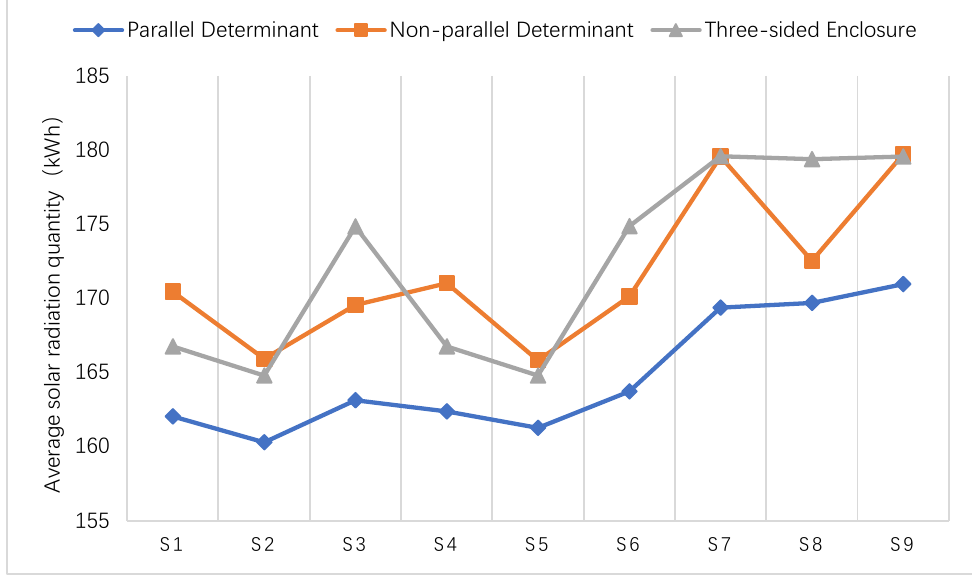
Figure 3. Solar radiation quantity of south facade S1–S9.